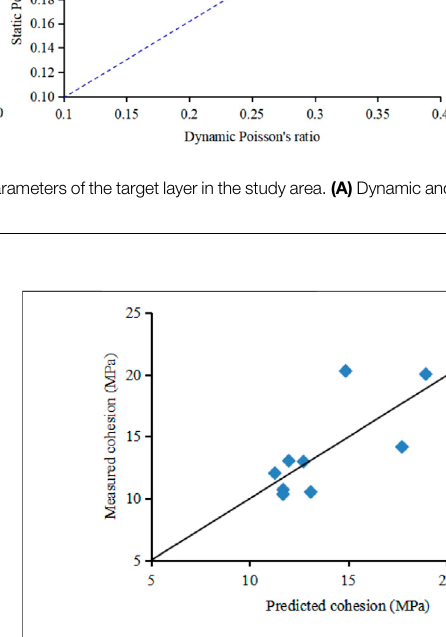
FIGURE 8 | Comparison of the tested and predicted values of the cohesion of the samples.